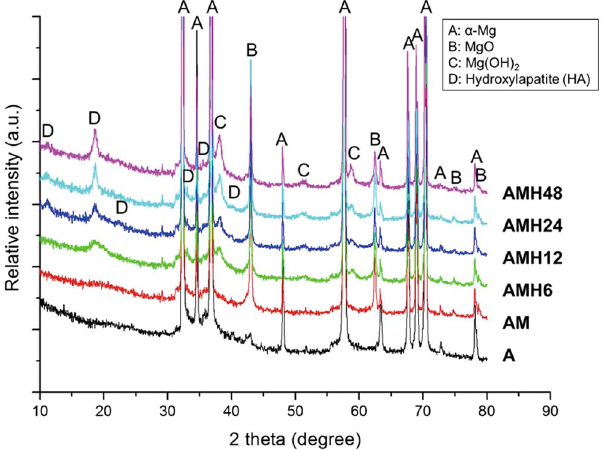
Figure 1(B and C) and Table 1(A) show the changes in surface composition with surface treatment. After MAO coating, the O, P, and Na ions were newly detected at the surface, and the concentration of O